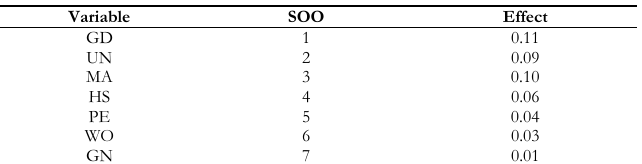
Effect of the 7 independent variables on the probability to graduate within one year logistic binomial regression